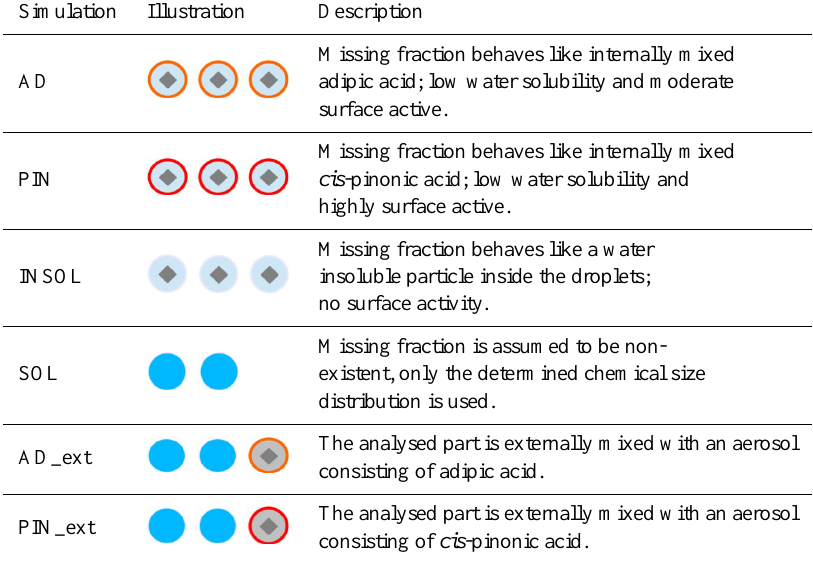
Table 3. Assumptions on the missing non-water soluble aerosol fraction used in the simulations. The droplet bulks show increasing ionic concentration moving from grey to blue. Orange and red droplet fringes show various degrees of depressions in surface tension, red being the strongest. Grey diamonds represent a core of water insoluble particles. Simulation Illustration Description Missing fraction behaves like internally mixed AD adipic acid; low water solubility and moderate surface active. Missing fraction behaves like internally mixed cis -pinonic acid; low water solubility and PIN highly surface active. Missing fraction behaves like a water INSOL insoluble particle inside the droplets; no surface activity. Missing fraction is assumed to be non- existent, only the determined chemical size SOL distribution is used.